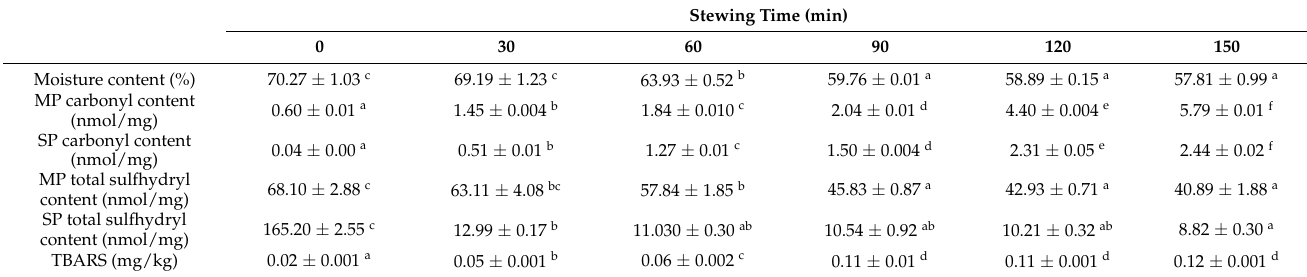
Table 2. Effects of stewing time on physiochemical properties of Sichuan-style braised